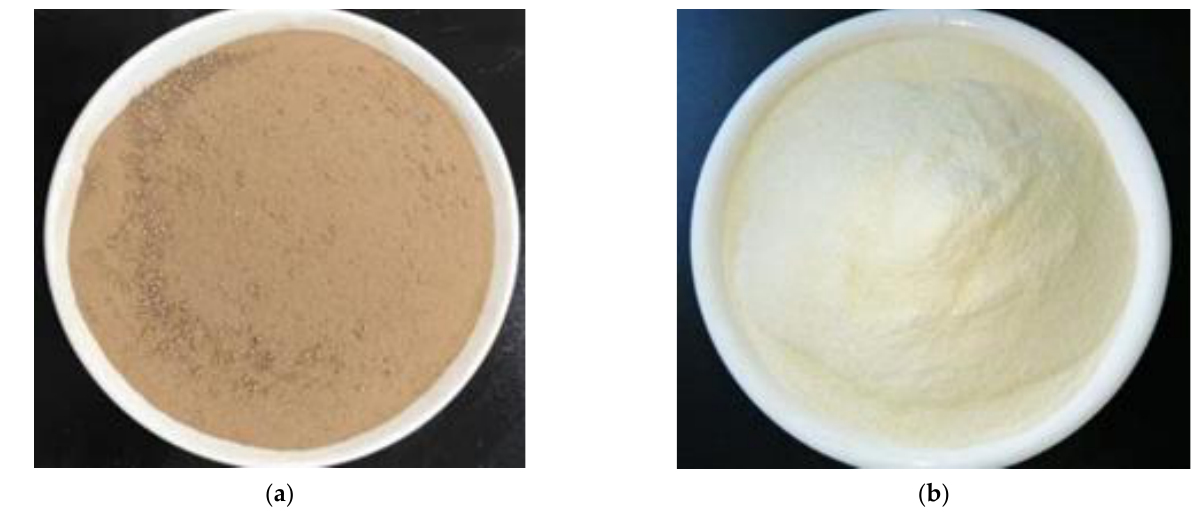
Figure 2. Samples of natural soil and xanthan gum: ( a ) silt; ( b ) xanthan gum.